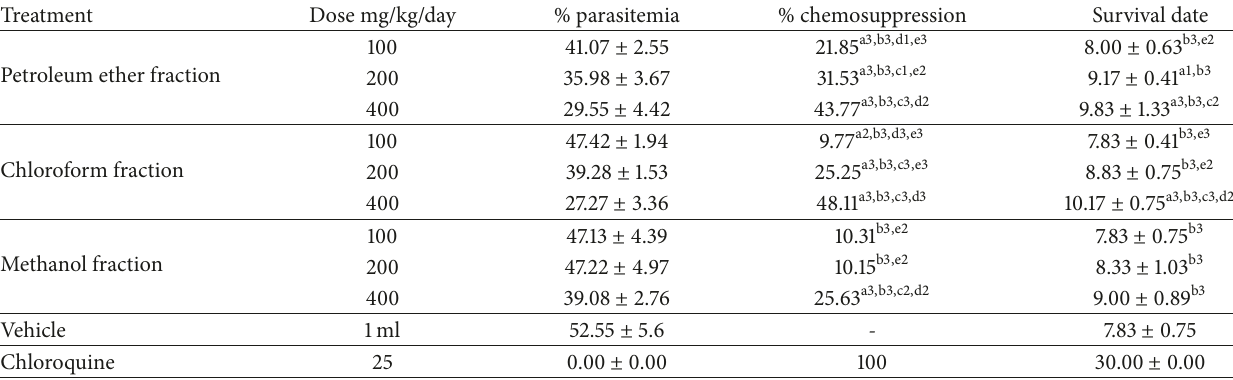
Table 2: Effect of the solvent fractions of C. papaya root on parasitemia and survival of infected mice with P. berghei on 4-day Peter’s suppression test.